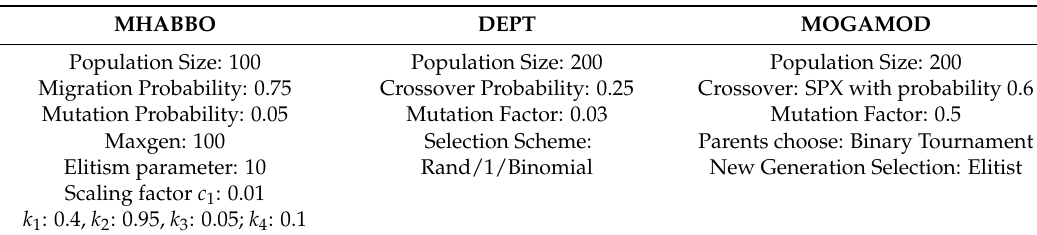
Table 6. Comparisons of three objectives and the motif predicted by MHABBO with different